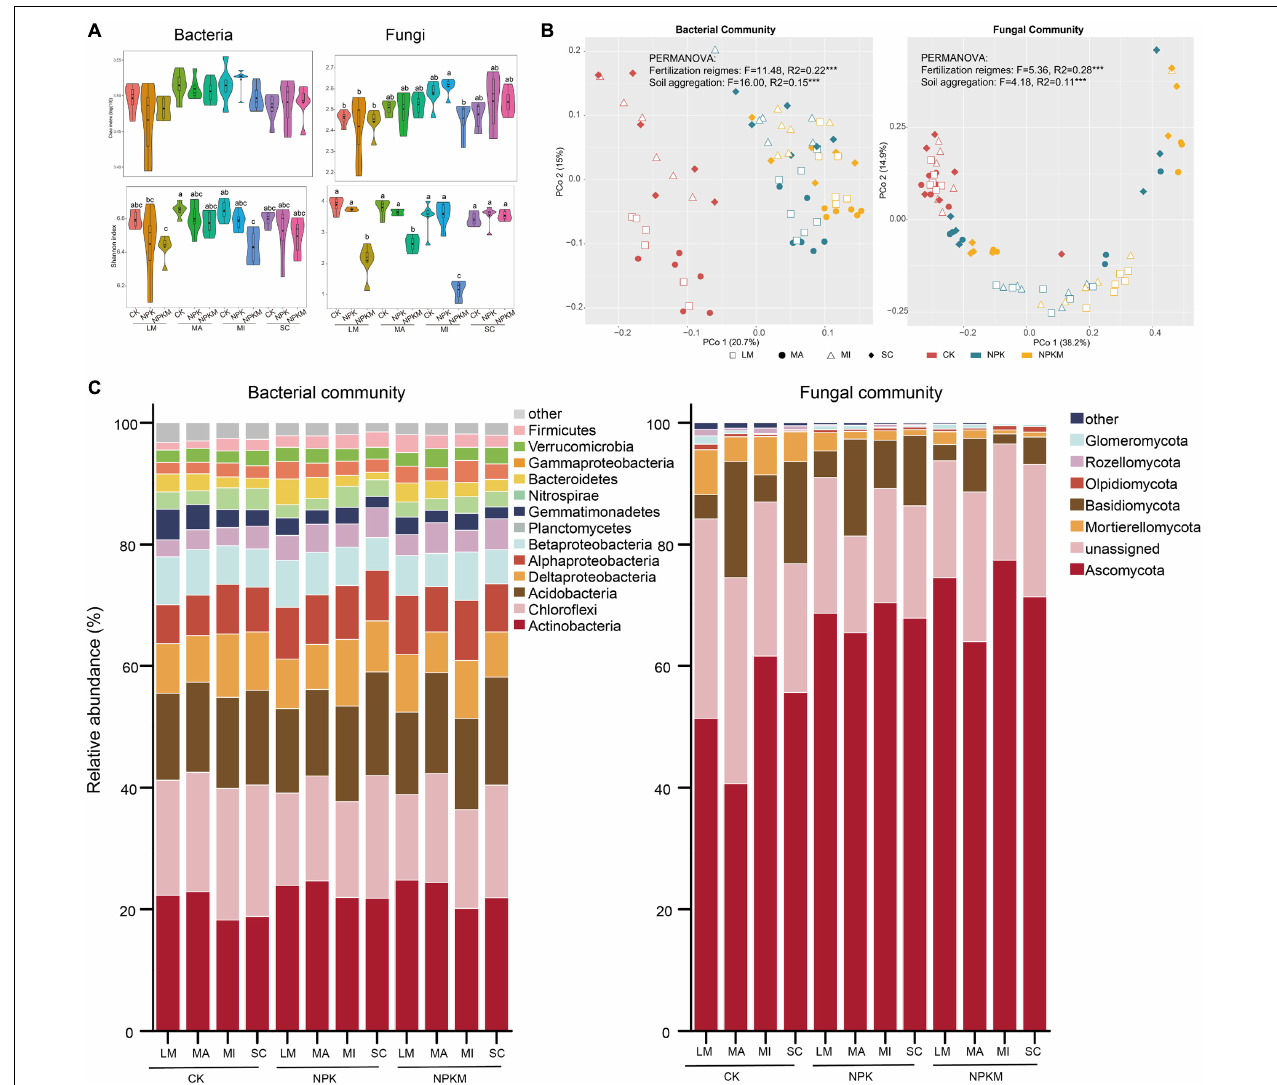
FIGURE 1 | Bacterial and fungal community compositions in different aggregate fractions under different fertilization regimes. (A) Alpha diversity [Chao (upper) and Shannon (below)] of soil bacteria (left) and fungi (right) community. The data of Shannon index was log-transformed. Different letters indicated significant difference at p < 0.05 (FDR corrected). (B) Unconstrained PCoA ordinations of bacteria (left) and fungi (right). Fertilization regimes are colored and aggregates are shaped by sample type. (C) Taxonomic profiles of bacteria and fungi communities at phylum level. Bacteria and fungi phyla with relative abundances lower than 1%